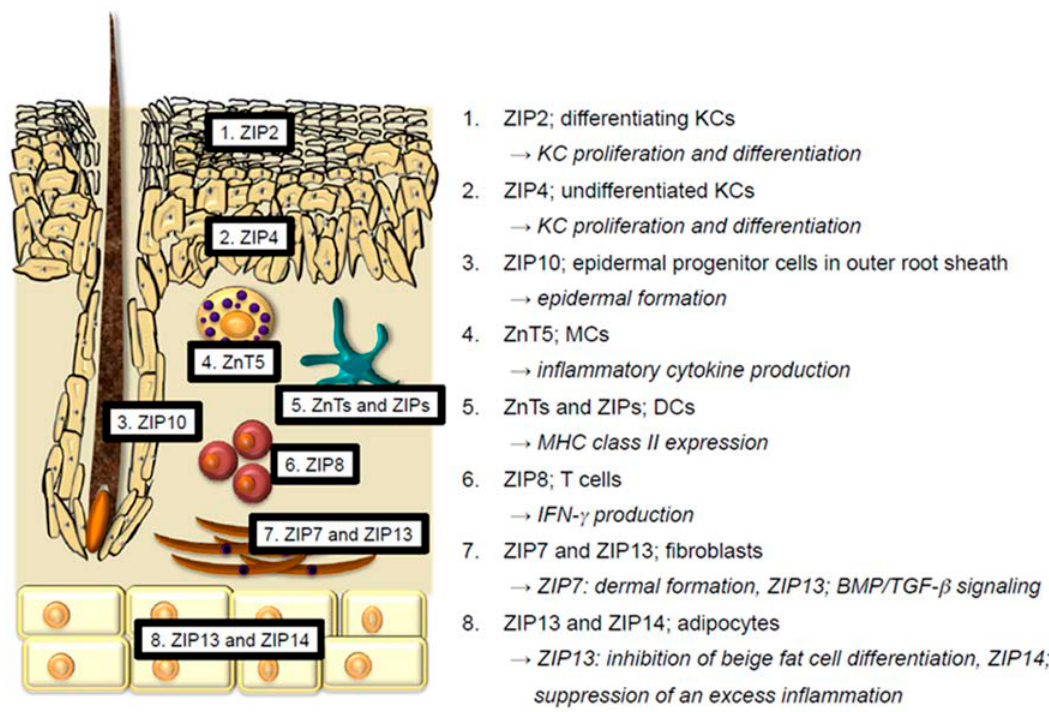
Figure 1. Reported distribution and function of Zn transporters in the skin. Every skin cell expresses many different Zn transporters. However, the expression and role of Zn transporters in skin cells are